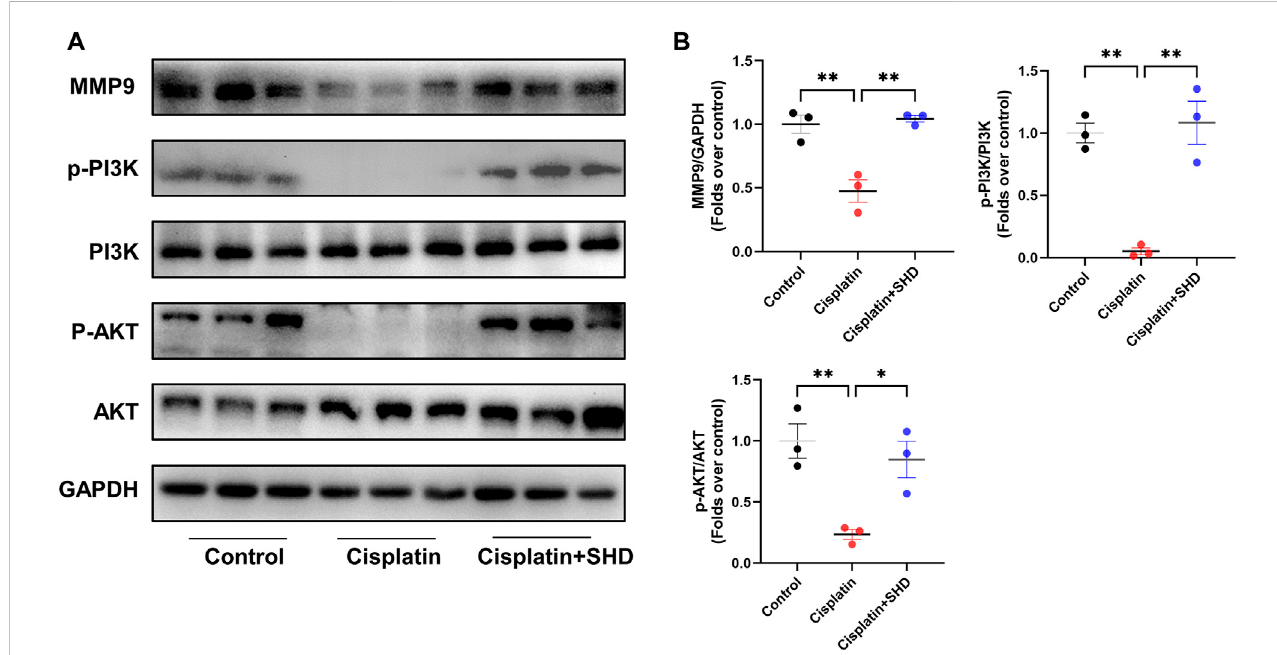
FIGURE 6 Effects of SHD on MMP9/PI3K/AKT pathway activity in the kidney. (A) Representative Western blot images of MMP9, phospho-PI3K, PI3K, phospho-AKT and AKT in the kidneys. (B) Densitometric analyses of MMP9, phospho-PI3K/PI3K, phospho-AKT/AKTproteins expression normalized to GAPDH content ( n = 3). Data presented are means ± SEM. p p < 0.05, pp p <